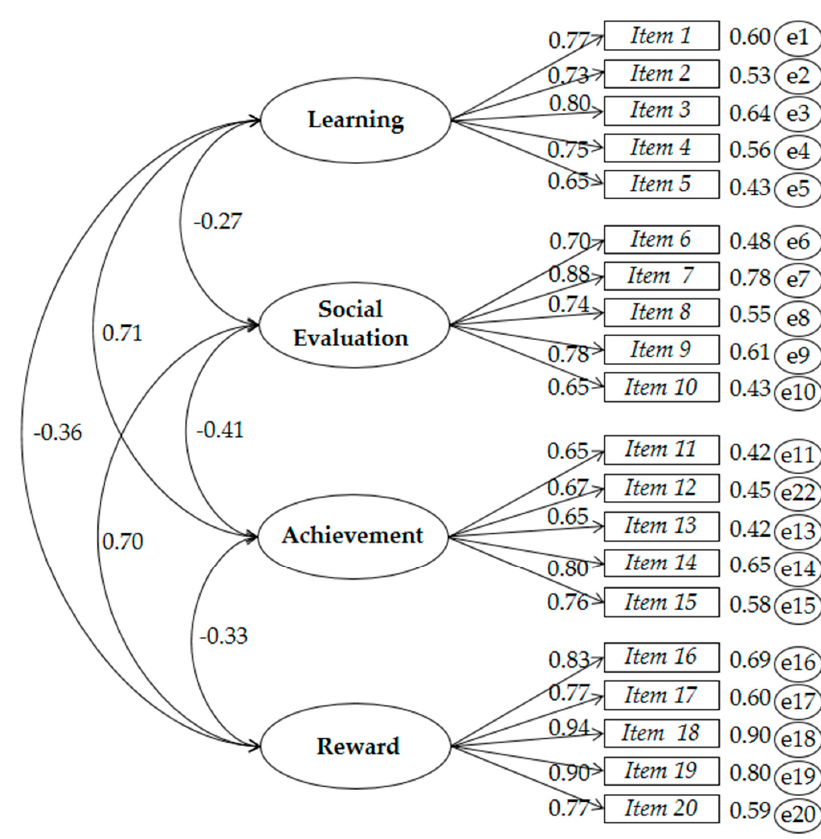
Figure 1. Model of four related factors of the Questionnaire of Academic Goals (QAG).